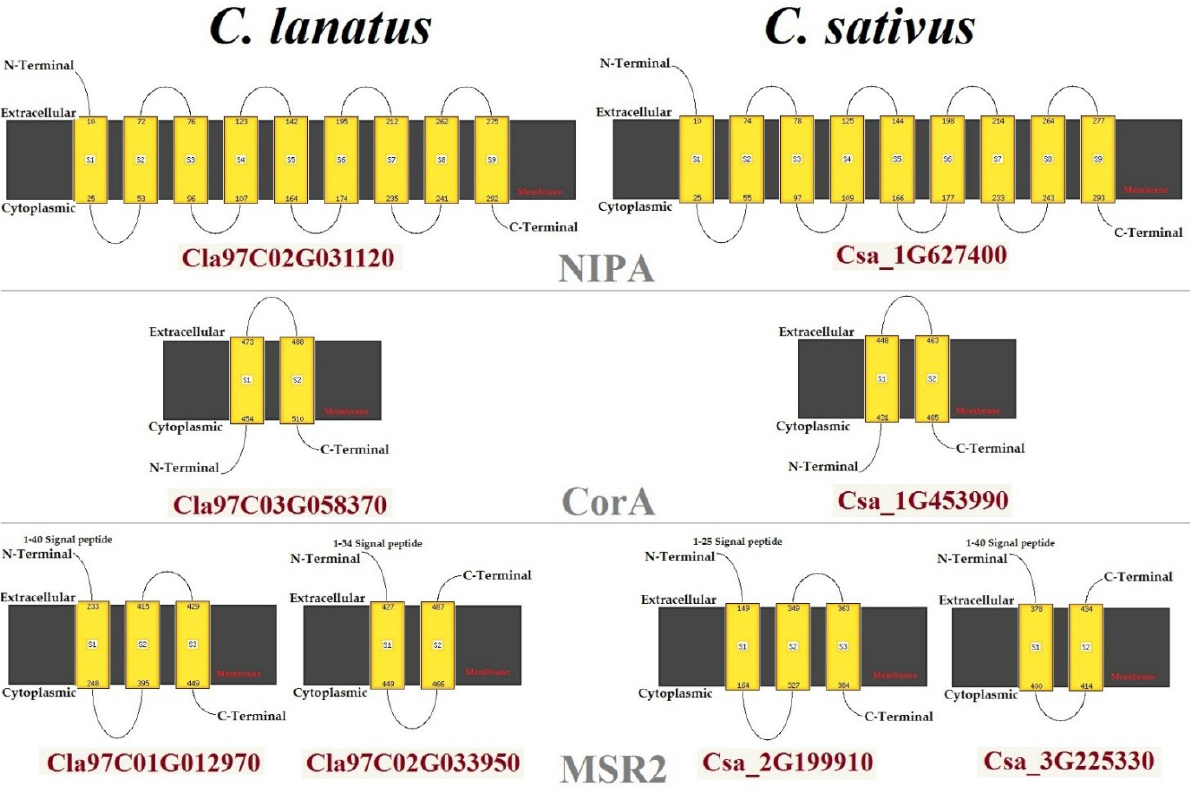
Figure 5. The distribution of transmembrane helices in various subclasses of MGTs in C. lanatus and C. sativus .